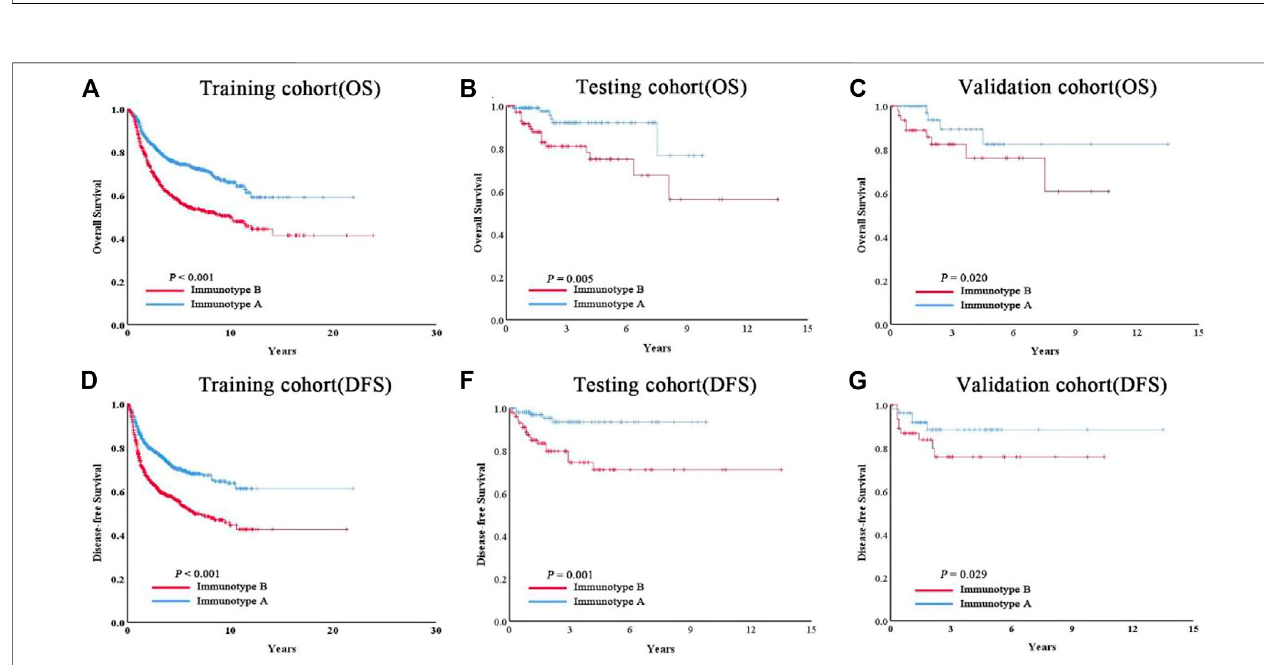
FIGURE 4 | Patients with immunotype B had signi fi cantly worse overall survival (A – C) and disease-free survival (D – F) than patients with immunotype A in all three cohorts.